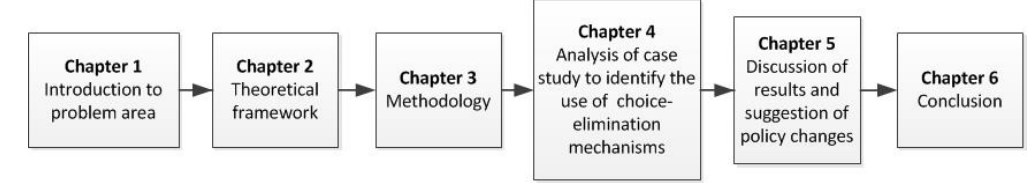
Figure 1. Overview of the research process.